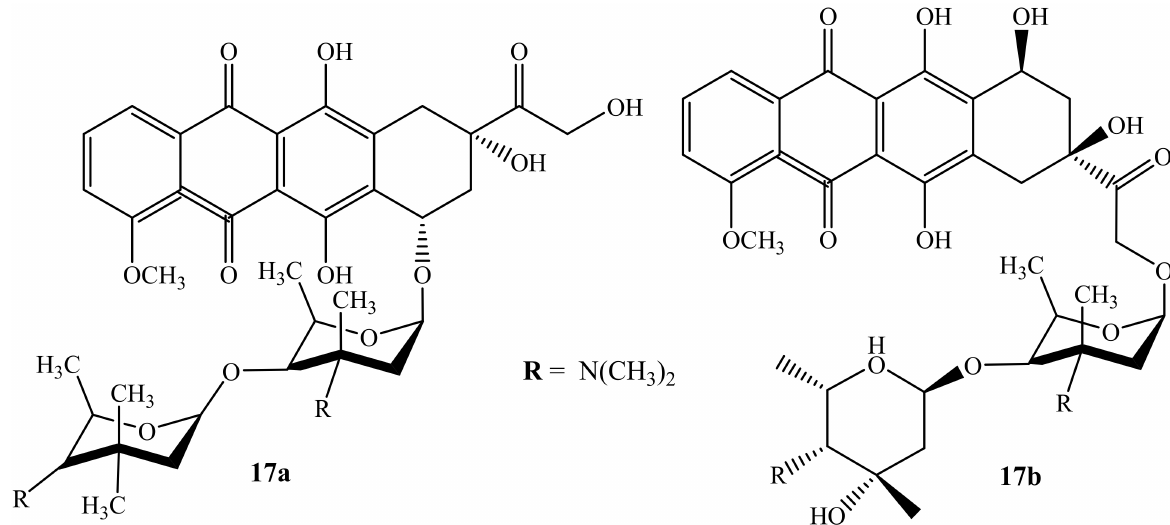
Figure 13. Chemical structure of doxorubicin modified by saccharides ( 17a – b